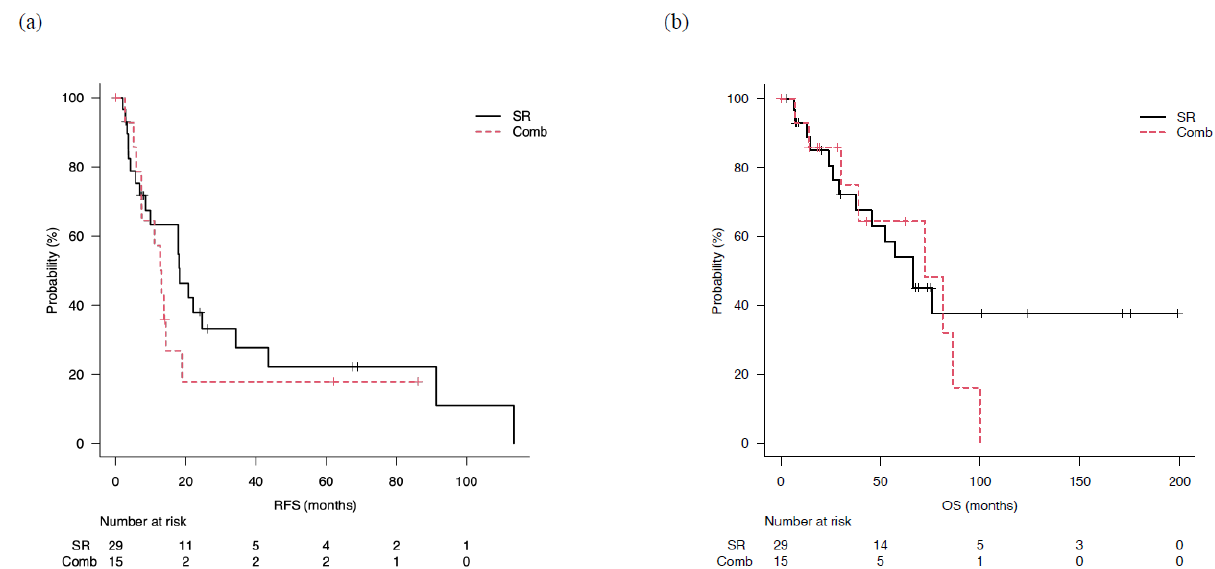
Figure 4. Outcomes in patients classified as beyond up-to-7 criteria who underwent surgical resec- tion (SR) or combined surgical resection and radiofrequency ablation therapy (Comb). ( a ) Median recurrence-free survival (mRFS) in the SR and Comb groups was 18.2 (95% CI: 8.5–34.3) and 13.0 (95% CI: 5.9–18.9) months, respectively ( p = 0.36). ( b ) Median overall survival (mOS) in the SR and Comb groups was 66.5 (95% CI: 29.4-not applicable) and 72.0 (95% CI: 30.2–86.2) months, respectively ( p = 0.57).